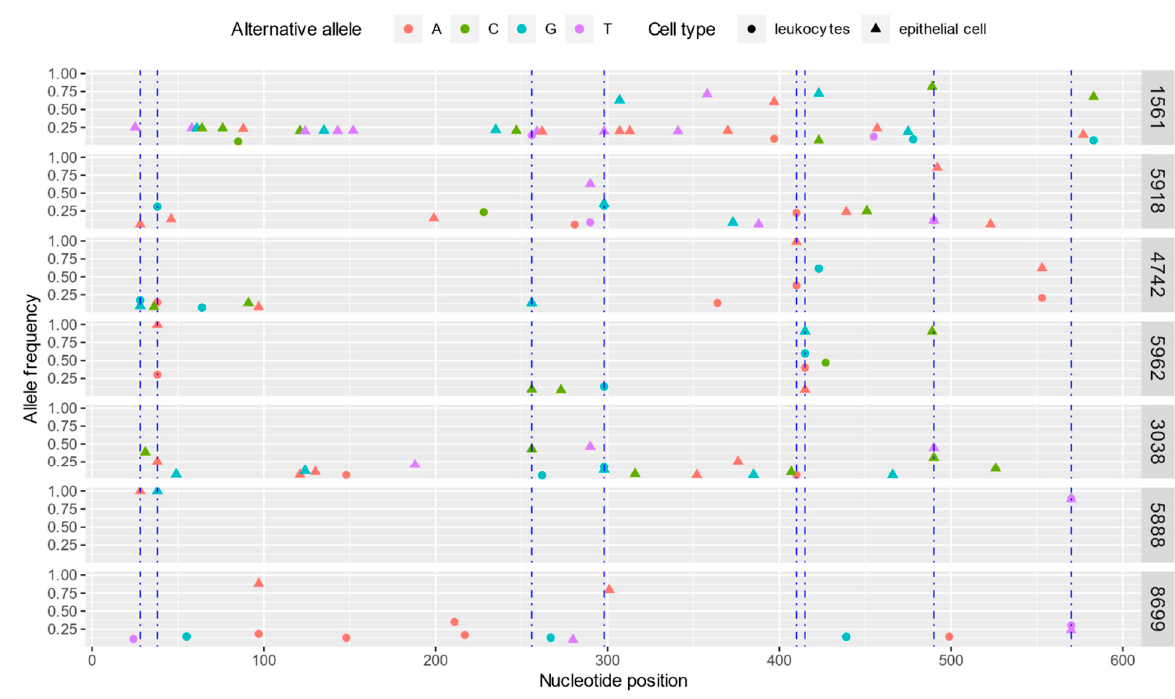
Figure 3. Distribution of single nucleotide variants (SNVs) in SRLVs gag genesequences encoding capsid protein derived from PBLs and milk epithelial cells (MEC) of goats analyzed in this study. The blue dotted lines indicate the hot spot mutations, where the number of SNVs was ≥ 4.